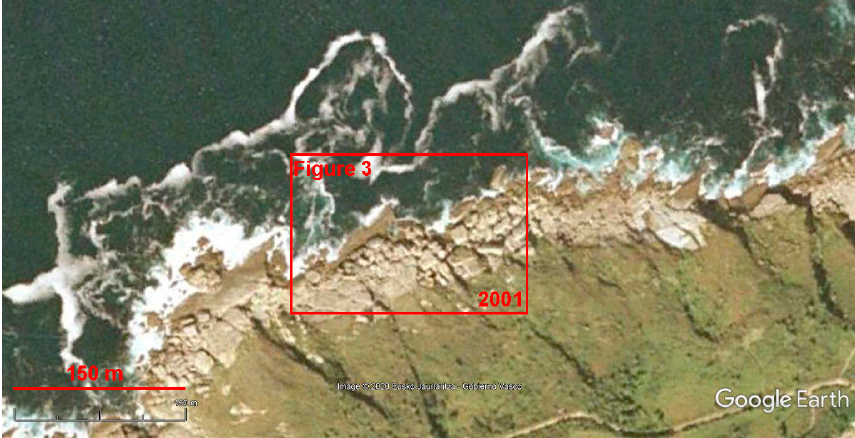
Figure 11. Satellite view of the western plot of the Hondarribia locality in 2001 (the view provided by the Google Earth Engine).